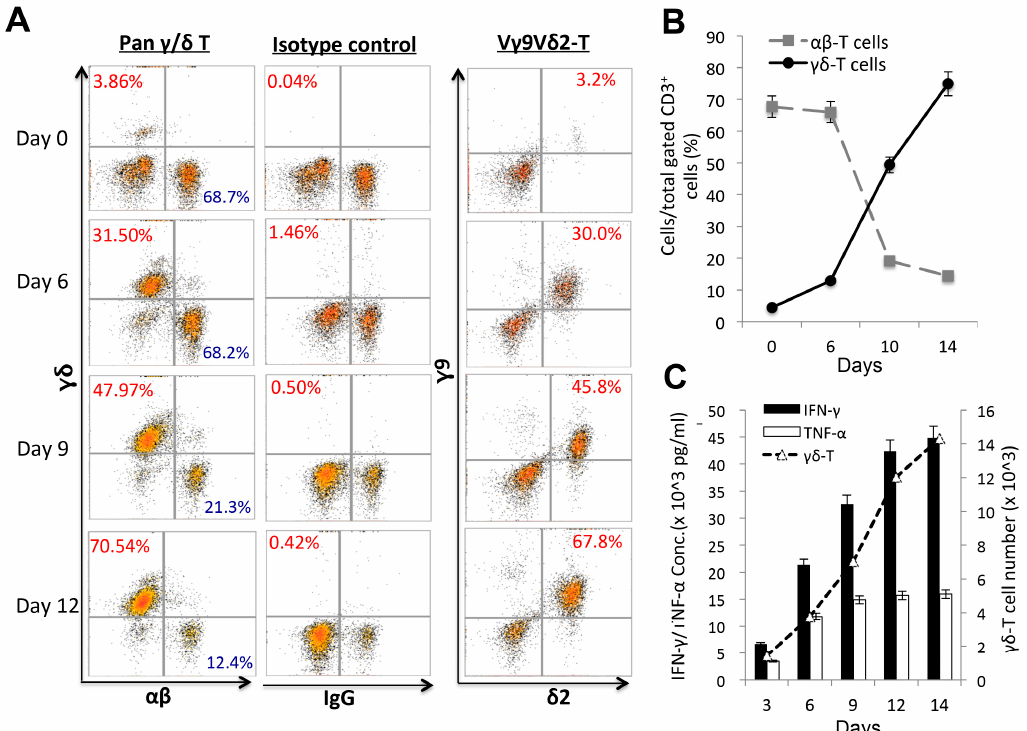
Figure 1. Ex vivo expansion of human peripheral blood mononuclear cell (PBMC)-derived V γ 9V δ 2 T-cells at different time points. Human PBMCs isolated from healthy separate donors were cultured with pamidronate (PAM) and rhIL-2, experiments were performed with many replicates ( n > 20). ( A ) Expanded percentages (%) of pan- γδ T-cell ( A , 1st panel), V γ 9V δ 2 T-cell subtypes ( A , 3rd panel) and the IgG control ( A , 2nd panel) were evaluated on days 0, 6, 9, and 12 during the culture period ( A , B ) using a flow cytometric analysis. ( C ) Cytokine levels (pg/mL) of interferon (IFN)- γ , tumor necrosis factor (TNF)- α , and the γδ -T cell real numbers were detected during the γδ -T-cell expansion period.